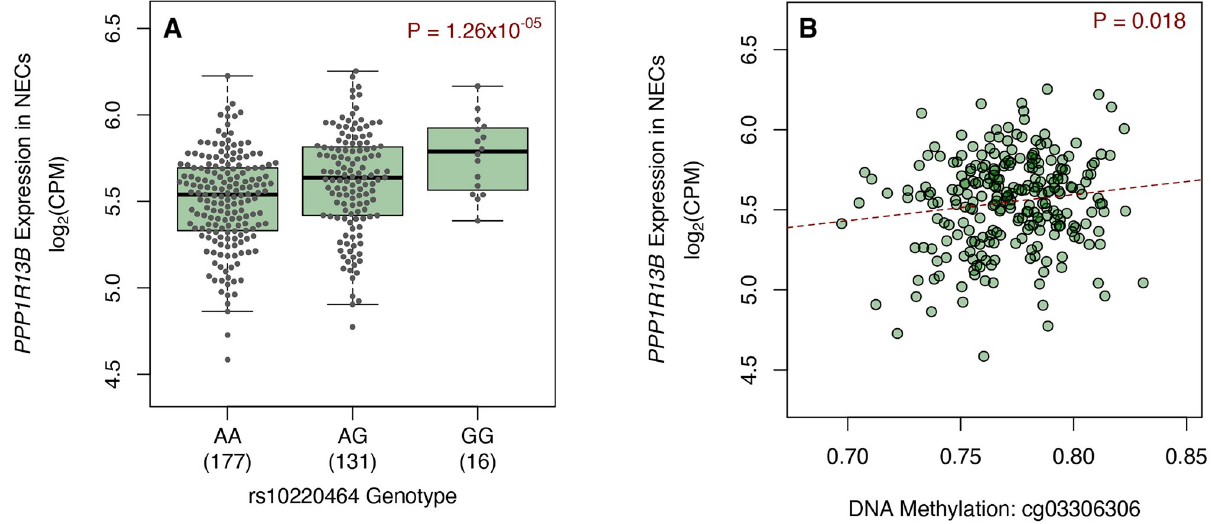
Fig 7. PPP1R13B gene expression in NECs. PPP1R13B gene expression in NECs at age 11 are plotted against A) rs10220464 genotype (n = 324) and B) DNA methylation at cg03306306 in NECs at age 11 (n = 254). NECs, nasal epithelial cells; CPM, counts per million.